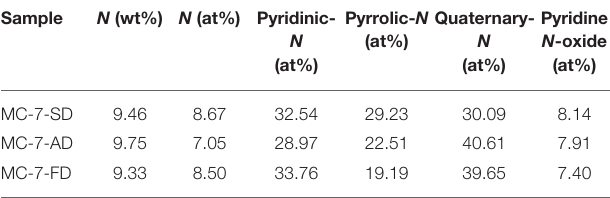
TABLE 2 | The nitrogen-doping content of MC-7-SD, MC-7-AD, and MC-7-FD.